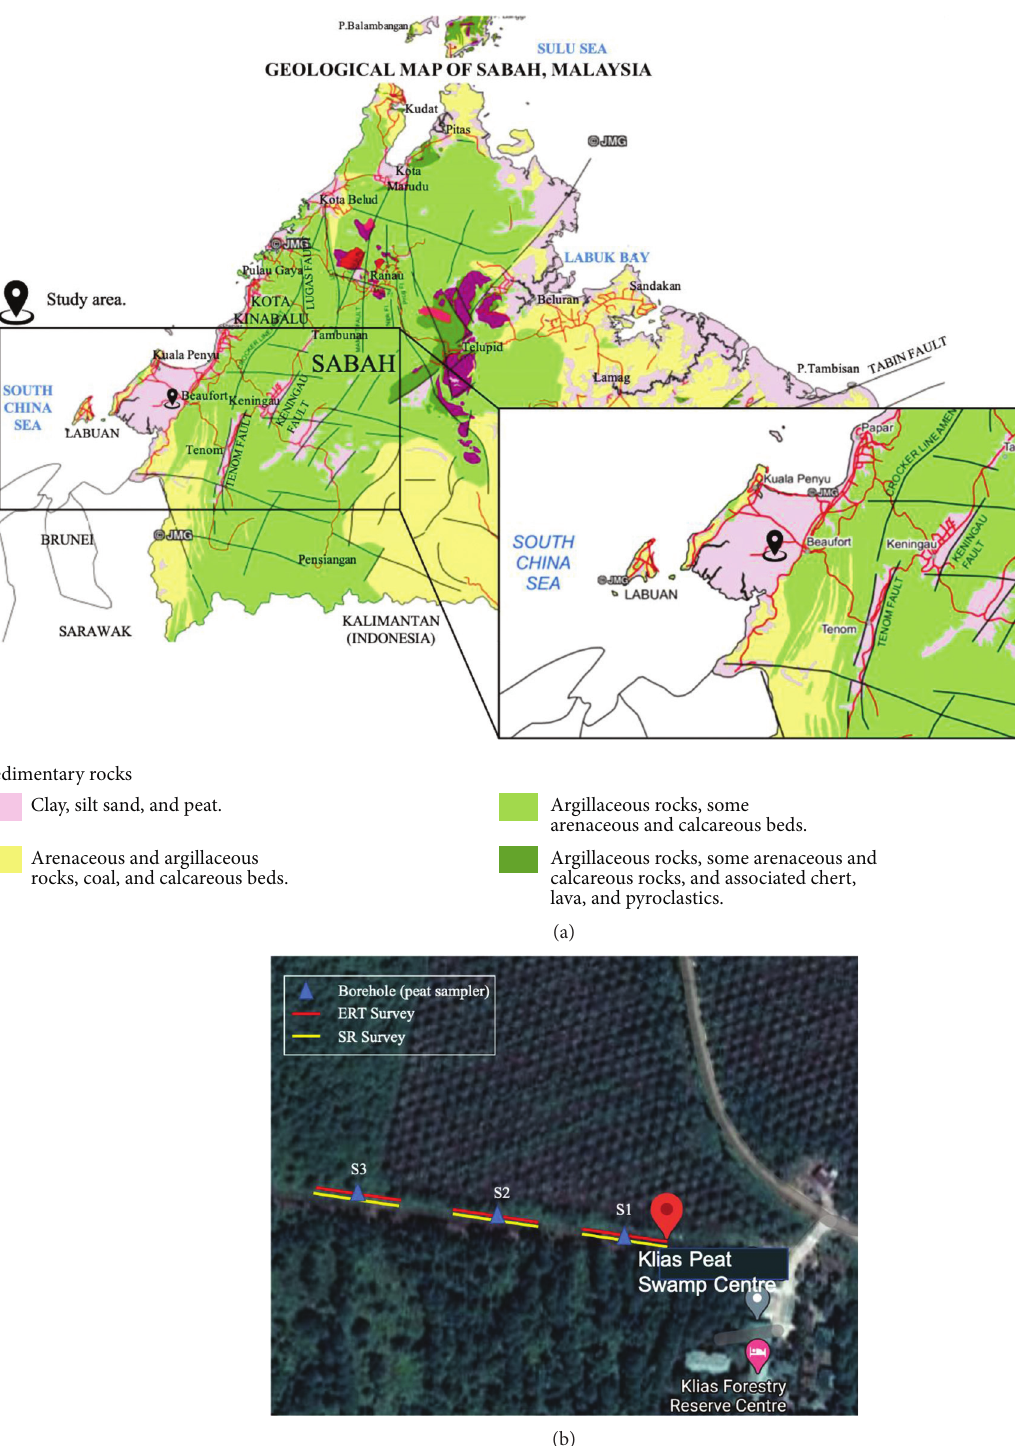
Figure 1: (a) Geological map of the study area. (b) Locations of the